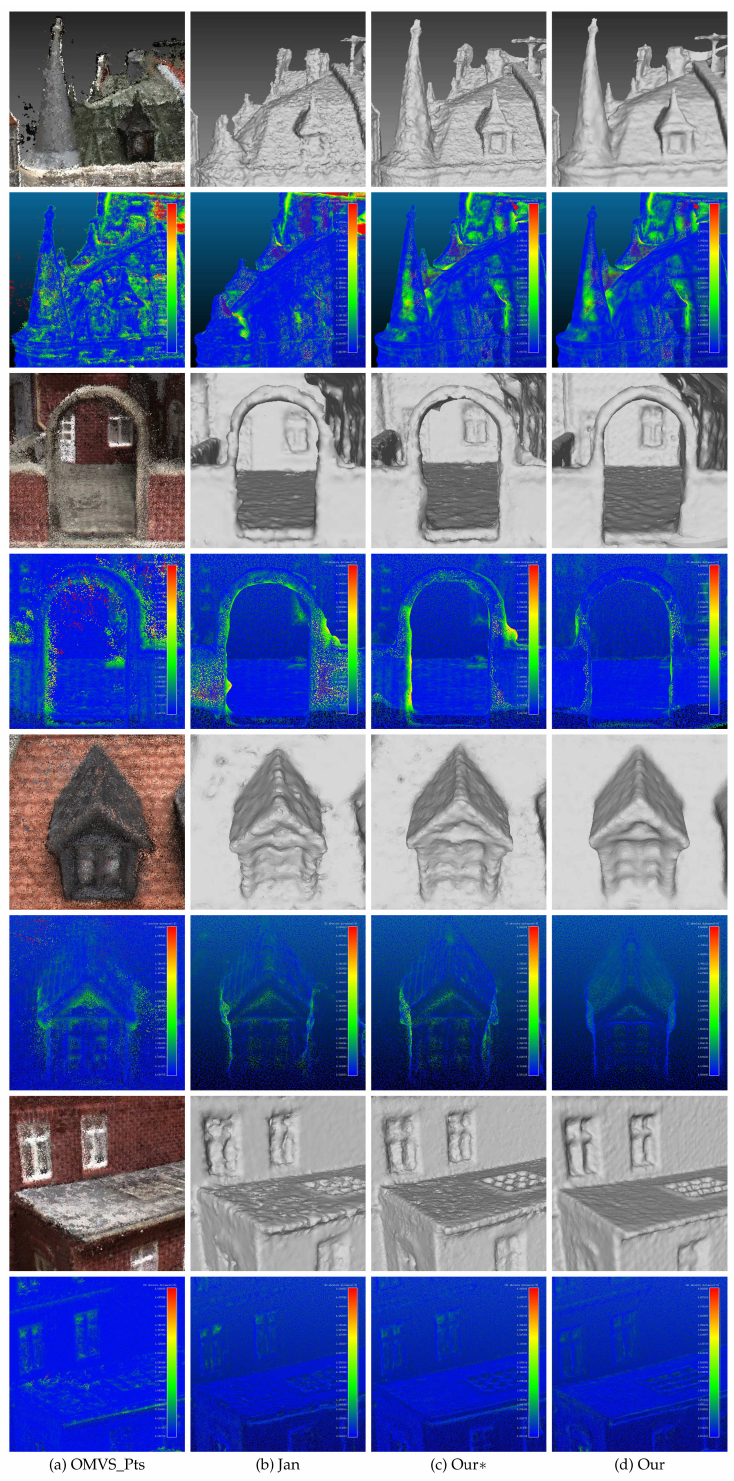
Figure 12. Detailed views of three methods on MVS dataset [2]. From left to right are: ( a ) the point cloud generated by OpenMVS; ( b ) the mesh of Jancosek and Pajdla [5]; ( c ) the mesh of the proposed method without the dense visibility technique; and ( d ) the mesh of the proposed method. In the even rows are the evaluation result (lower is better) of the corresponding local models in the odd rows through the method in [41]. The unit is mm for all